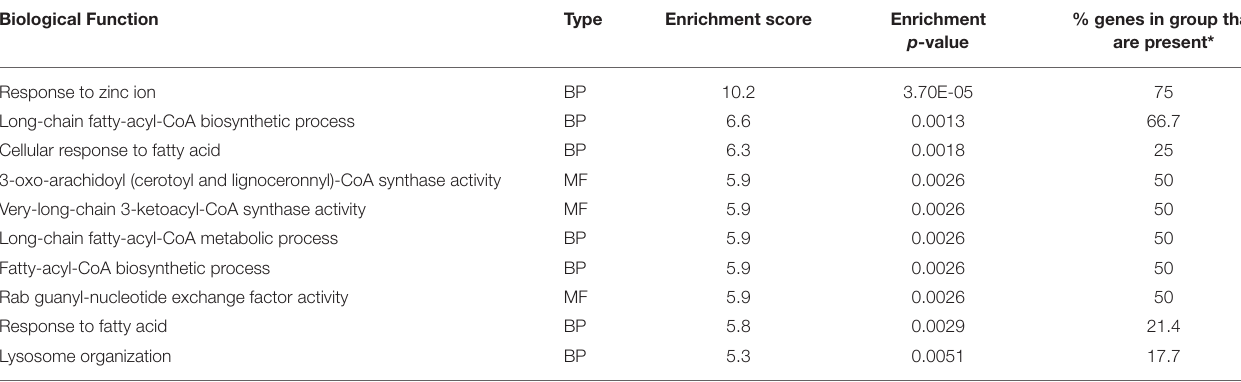
TABLE 2 | Top 10 most significant gene ontology (GO) terms for the differentially expressed genes in vitrified morulae. Biological Function Type Enrichment score Enrichment